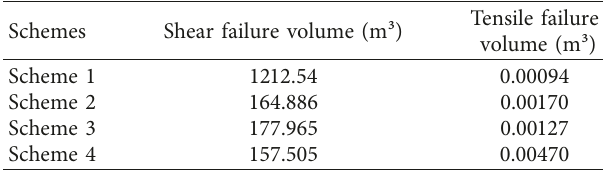
Table 4: Volume of the plastic zone after the third step.